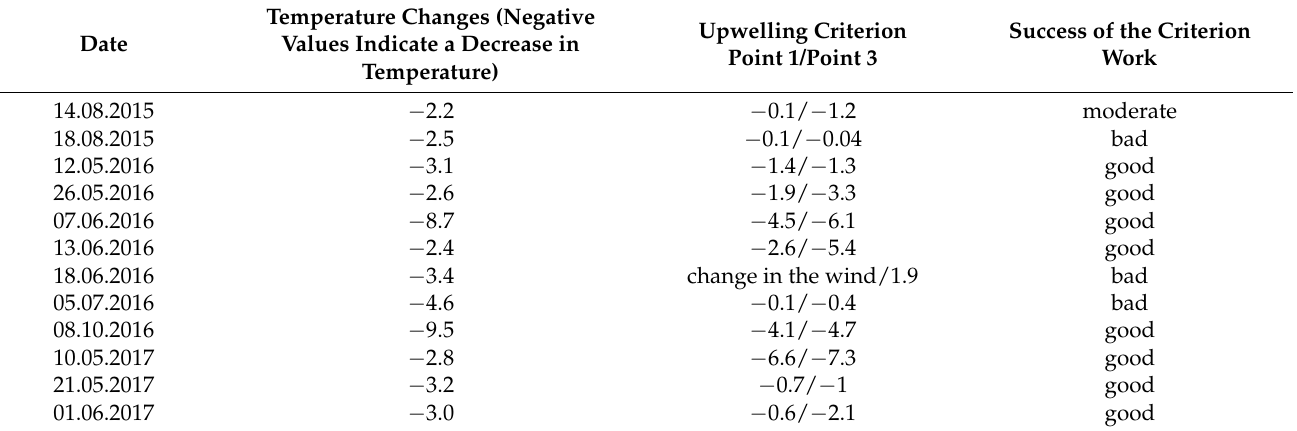
Table 2. The events selected based on the temperature decrease (2 ◦ C or more) and calculated upwelling